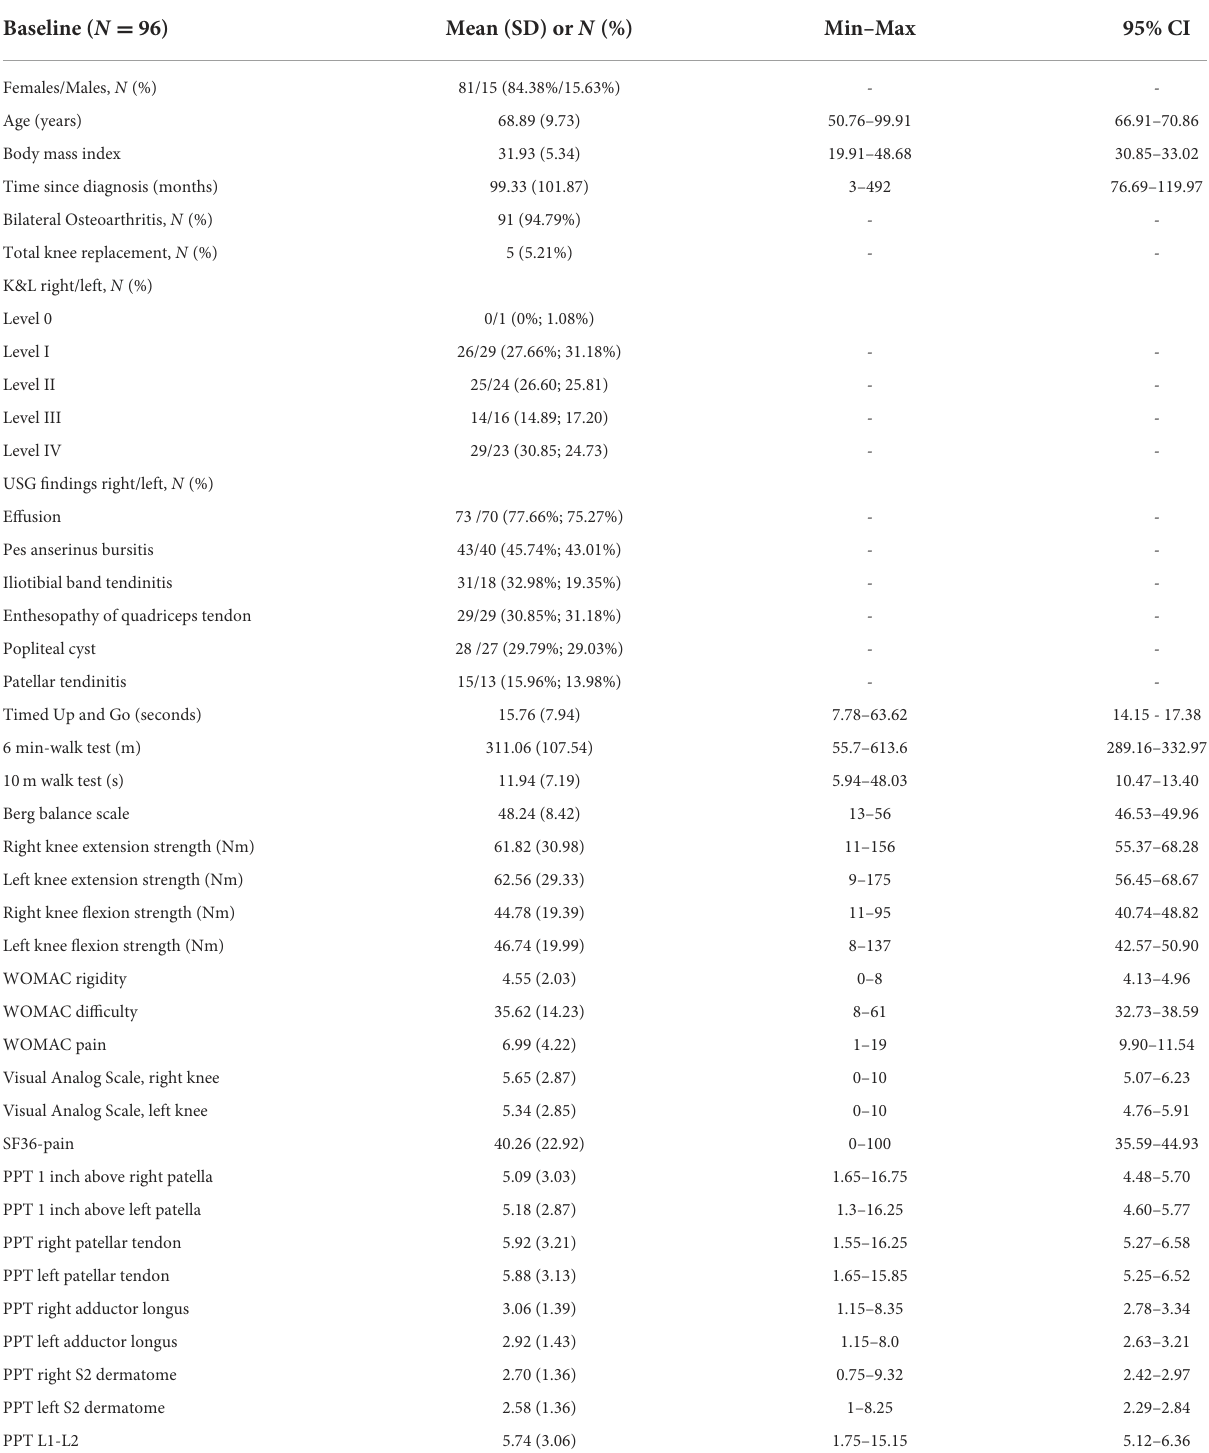
TABLE 1 Patients characteristics at